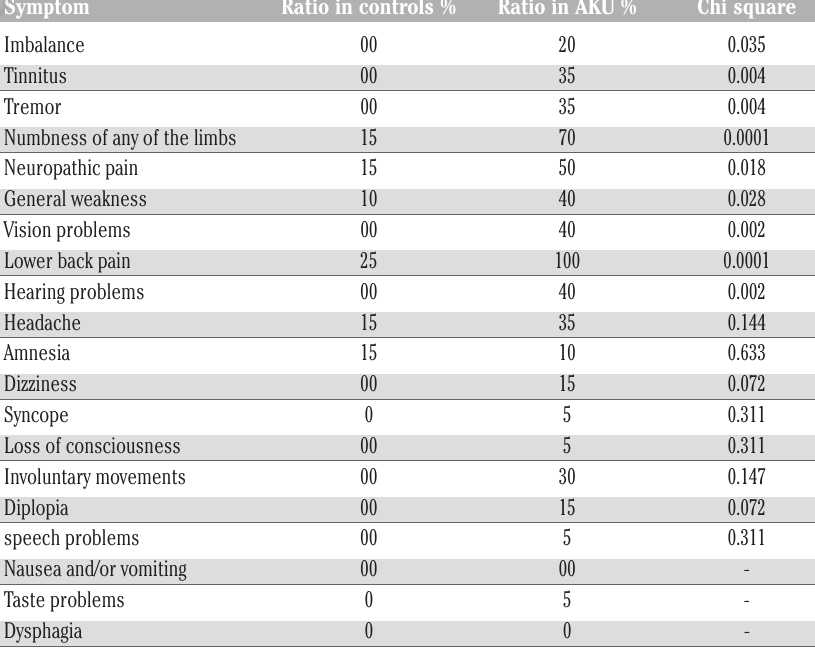
Table 2. Prevalence of neurological symptoms in alkaptonuria (AKU) patients and con-